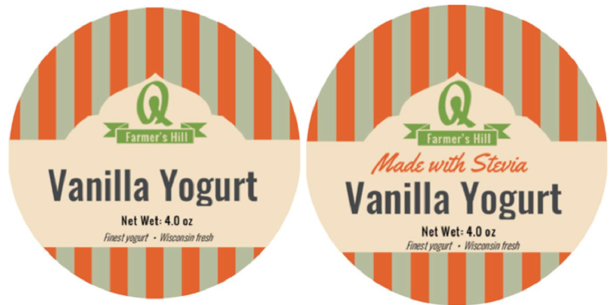
Figure 1. Labels used to identify samples denoting no claims (control) and label showing “Made with Stevia” claim.